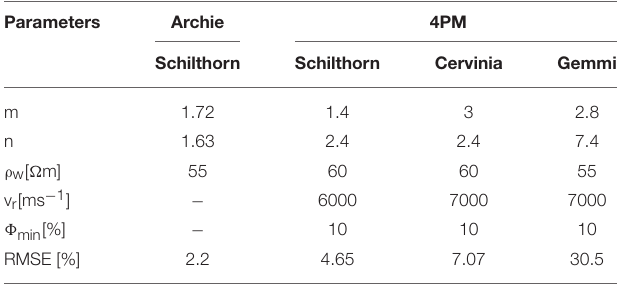
TABLE 2 | Summary of the parameters selected for Archie’s law at Schilthorn and the 4PM ones at each sites. Parameters